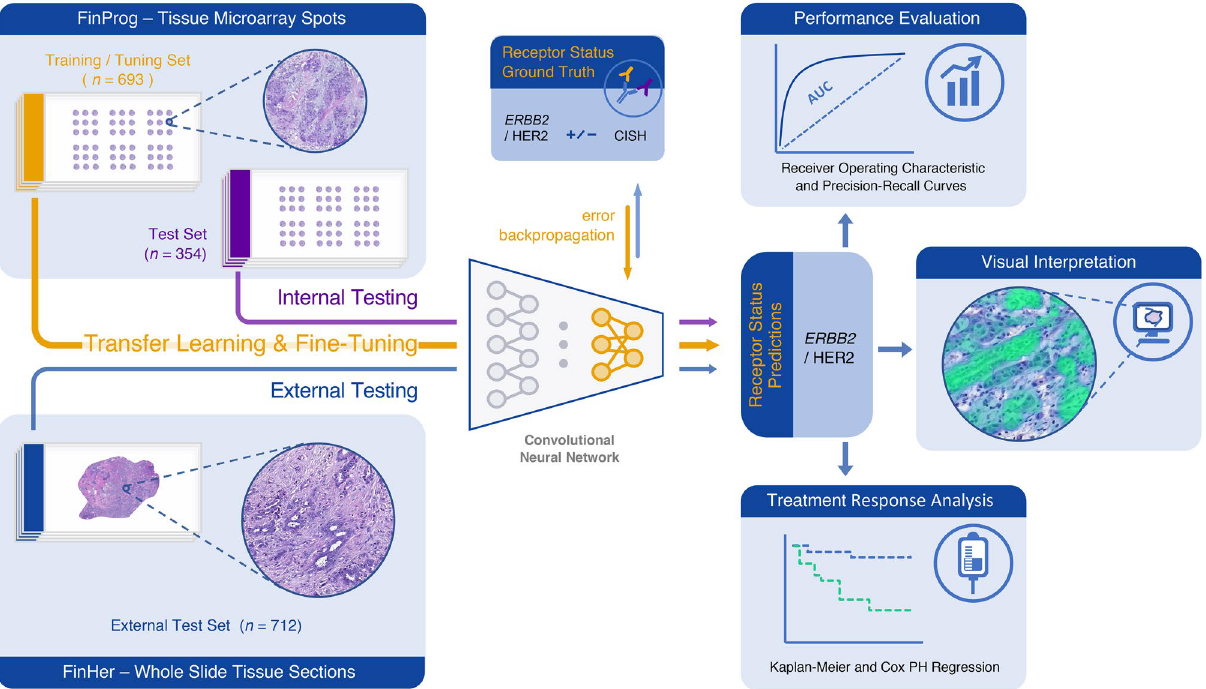
Figure 1. Flow chart of the study design. Deep convolutional neural networks were trained on hematoxylin and eosin stained tissue microarray spots from a nationwide breast cancer series (FinProg) to predict the ERBB2 gene amplification status of the primary tumor. The networks were trained using a transfer learning approach with ImageNet pretrained weights, and only the deepest layers (colored in yellow) were finetuned by minimizing the focal loss, weakly supervised by the ground truth ERBB2 gene amplification status as determined by chromogenic in situ hybridization. At the test phase, the networks generate probabilities of ERBB2 amplification (the H&E- ERBB2 score). The classification accuracy was summarized with receiver operating characteristic and precision-recall curves. Additionally, we applied Kaplan–Meier plots and Cox regression analysis to correlate the H&E- ERBB2 scores with patient treatment outcome